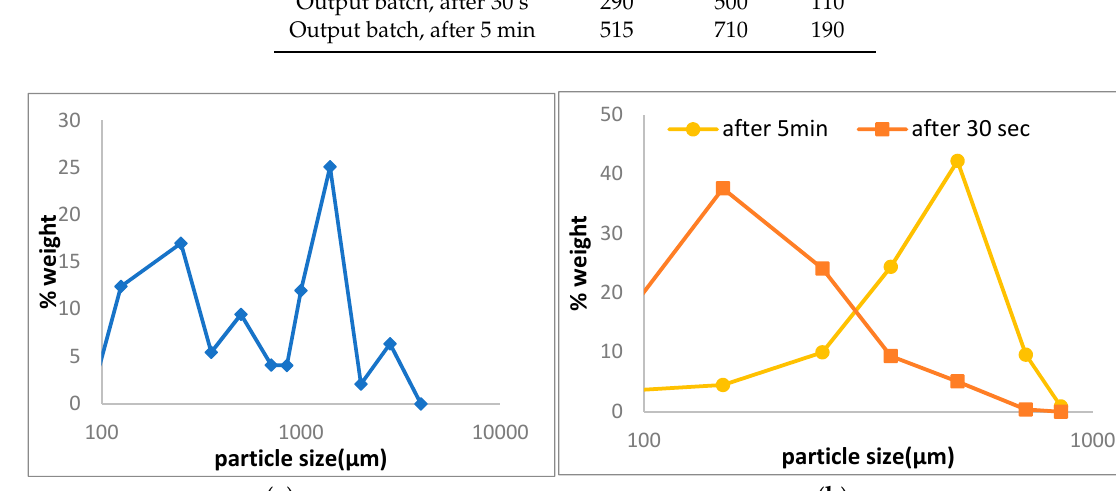
Figure 5. Input batch PSD ( a ), output batch PSD ( b ).